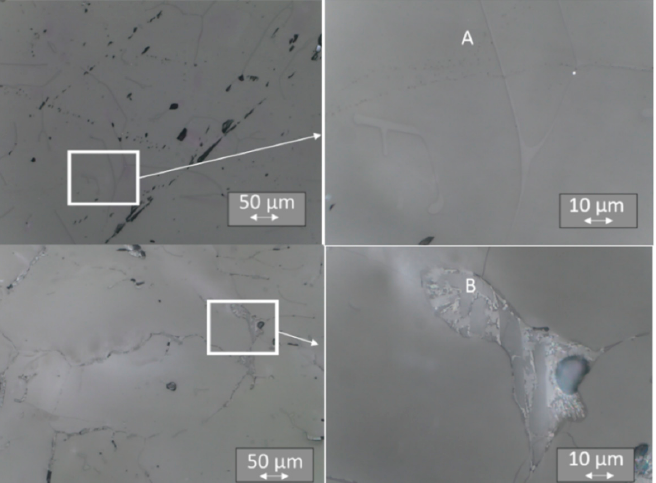
Figure 13. Microstructure of LMP doped with 0.8-mol% Tm and 10-mol% B. Top panels ( A )—sample No. 7 at a magnification of 200× (on the left) and 1000× (on the right); bottom panels ( B )—sample No. 22 at a magnification as above. The inset on the left has been further magnified on the right.